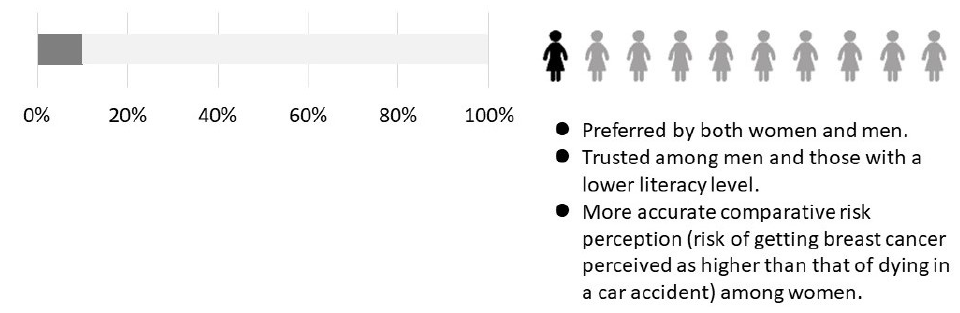
Figure 1. Summary of main findings.